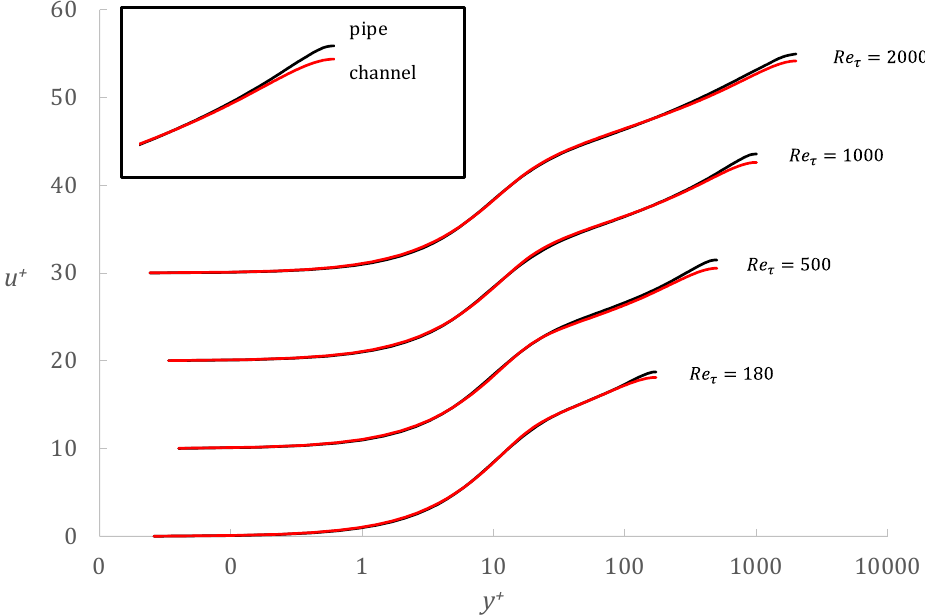
Figure 7. MVP; – pipe DNS database [26]; and – channel ITM model. The plots are shifted vertically Figure 7. MVP; ─ pipe DNS database [26]; and ─ channel ITM model. The plots are shifted vertically by 10 units. by 10 units.